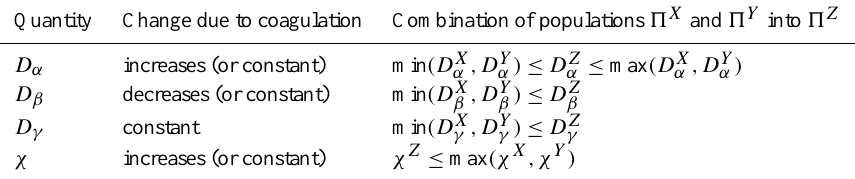
Table 5. Change in population diversities and mixing state index due to change in the particle population. For population combinations the superscript indicates the population for which a quantity is evaluated. For coagulation, D α , D β , and χ stay constant when all particles have identical mass fractions. See Theorems 2 and 3 for precise